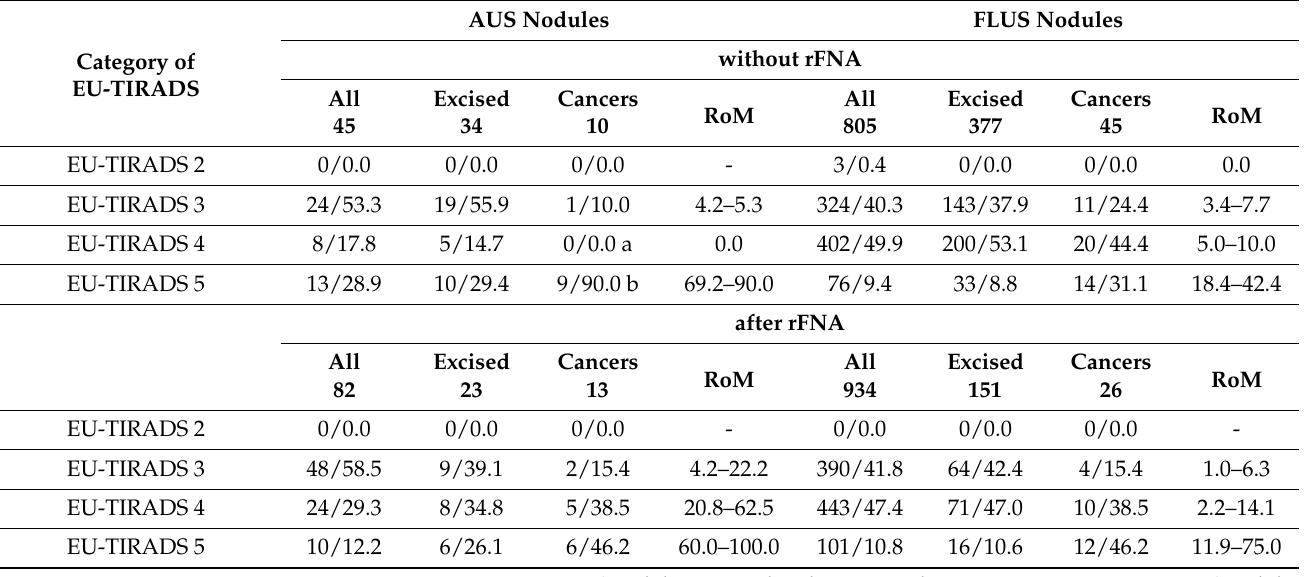
Table 3. Comparison of the risk of malignancy (RoM) in AUS and FLUS nodules in patients treated surgically without or after rFNA for particular EU-TIRADS